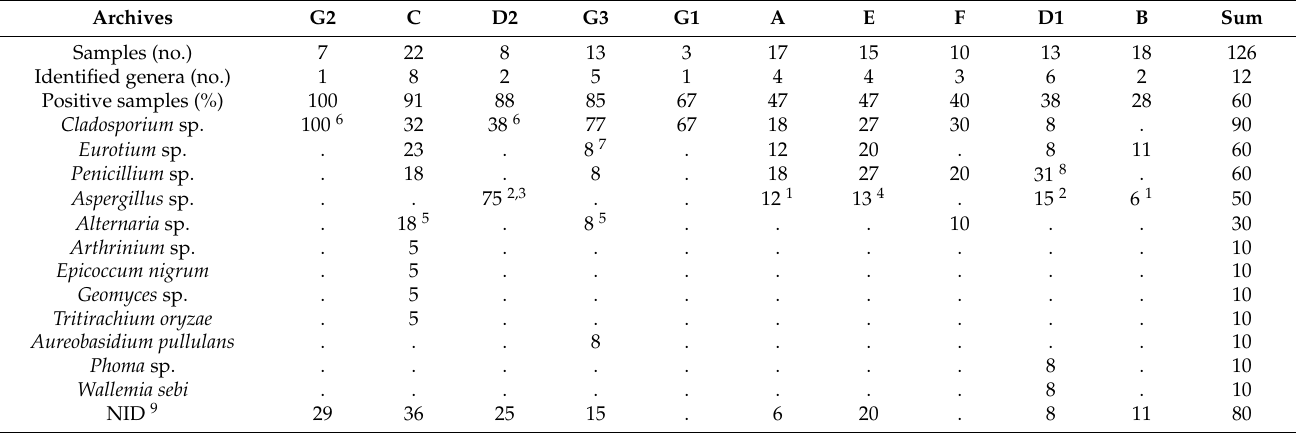
Table 1. Fungal contamination from single archives regarding the percentage of samples positive for fungal contamination (CFU ≥ 1) and genera and species